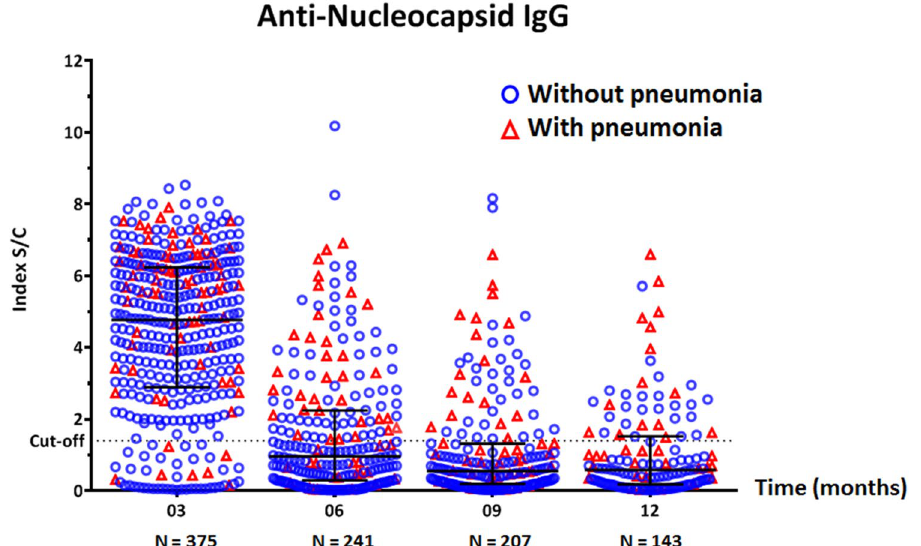
Figure 2. Scatter dot-plot with median and interquartile range (IQR) showing the distribution of SARS-CoV- 2-anti-nucleocapsid IgG S/C index in serum samples of COVID-19 patients at 3, 6, 9, and 12 months after symptom onset or first SARS-CoV-2 detection by RT-PCR. Red triangles and blue circles represent patients with and without pneumonia symptoms,